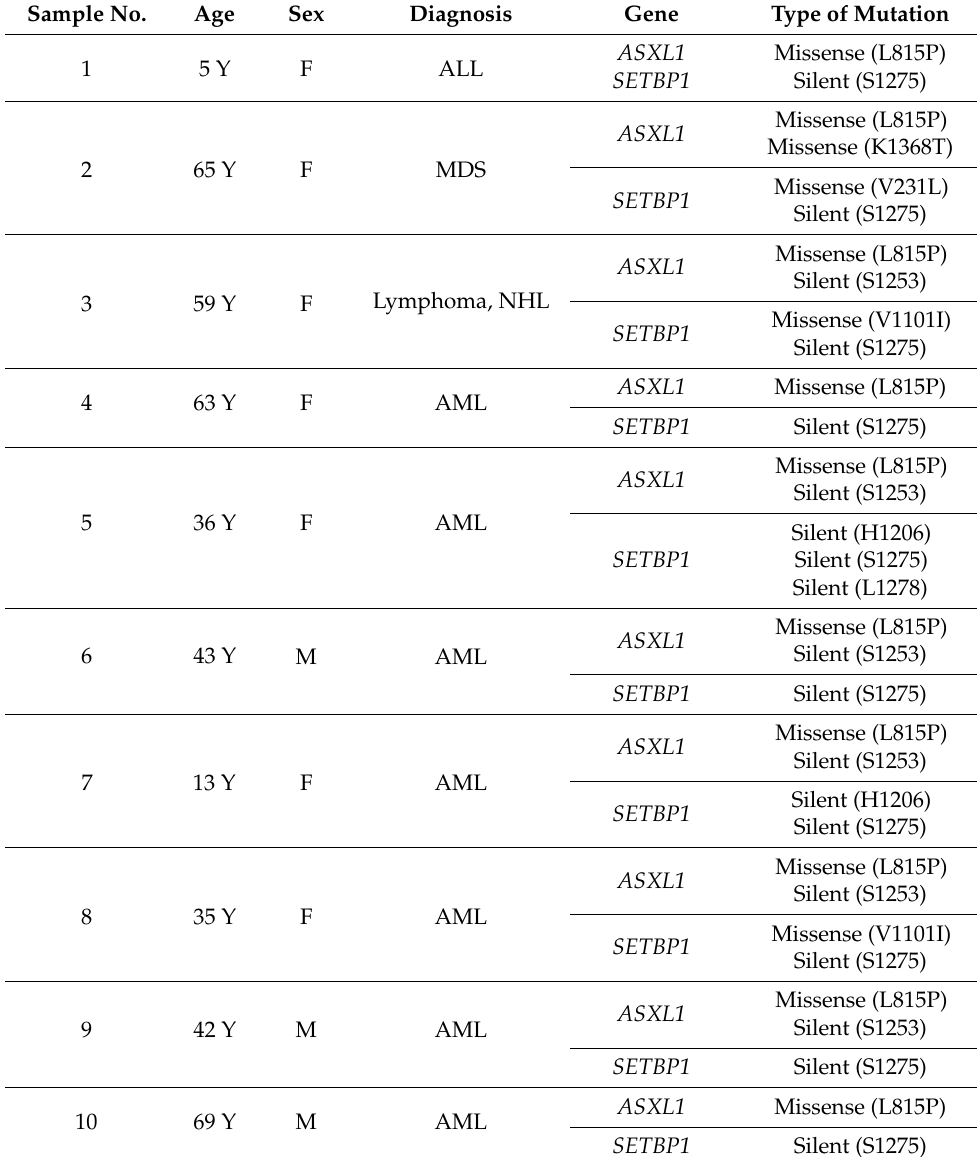
Table 6. ASXL1 & SETBP1 mutations in all cases. The mutations marked with red color represent the exclusive association with TP53